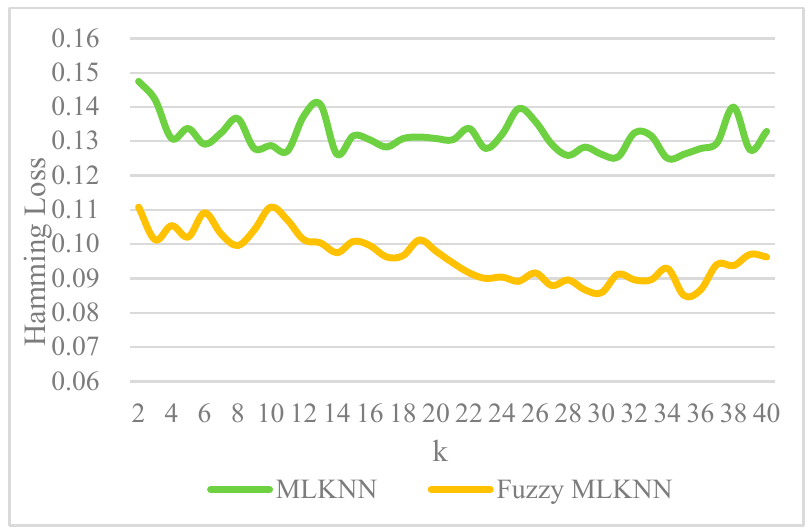
Figure 1. HammingLoss values under different K values.